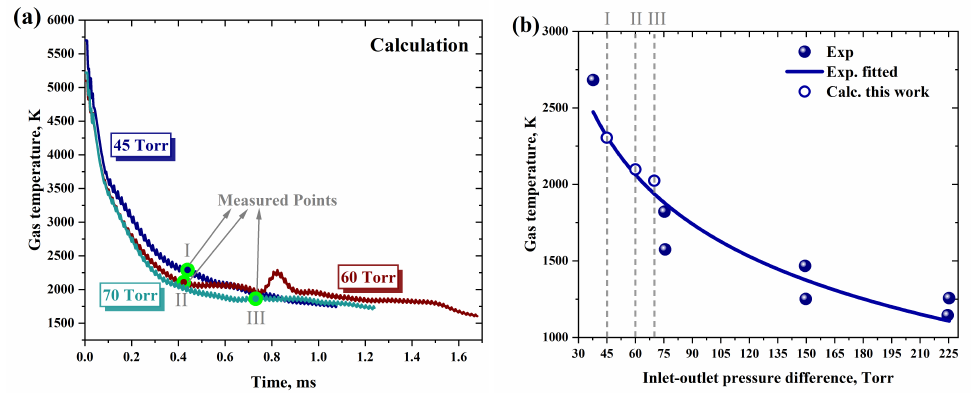
Figure 6. ( a ) The evolution of the calculated gliding arc temperature at various inlet-outlet pressure differences. The gliding arc temperature 10 ms from the outlet is indicated by the green cycles. The time 0 ms correspond to the re-ignition moment. ( b ) Comparison of the gliding arc temperature between the measurement [34] and simulation.